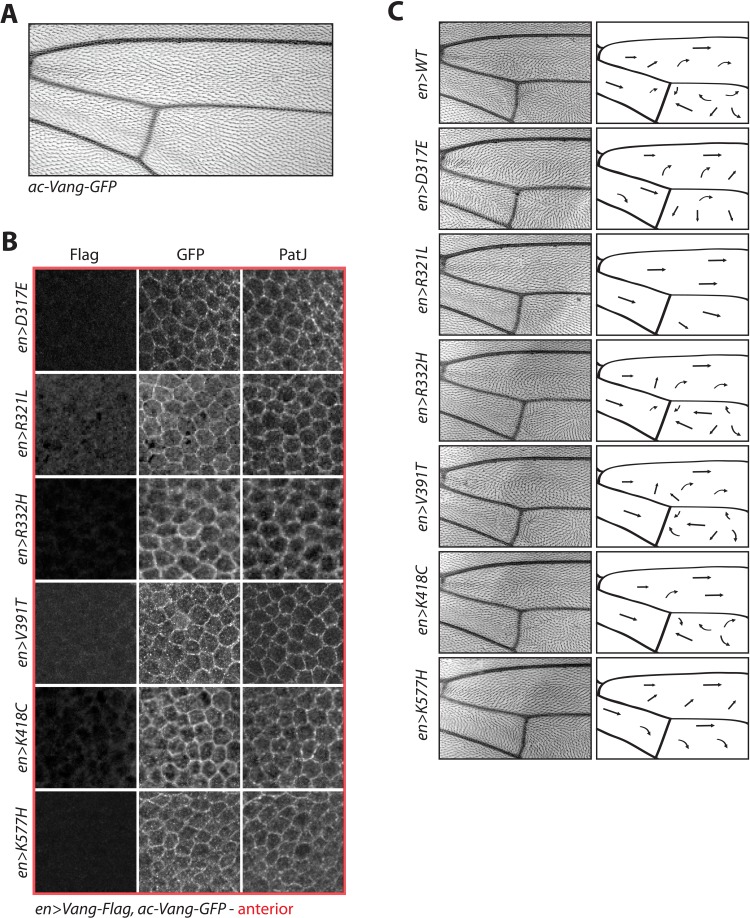
Expression of ac-Vang-GFP within the Drosophila wing blade does not interfere with polarity.(A) Image of adult wing expressing a direct driven ac-Vang-GFP transgene. Note that no hair reorientation defects are observed confirming that expression is within the homeostatic range. (B) Representative immunofluorescence images of regions from the anterior compartment of wings, the region of the wing in which engrailed-Gal4 driven constructs are not expressed. Note similarity in staining between Vang-GFP and PatJ in each condition. (C) Schematic of adult wing showing hair reorientation phenotypes in the indicated genotypes. Arrows show general flow of hair reorientation, note the similarity in pattern between overexpression of WT, R332H, V391T and K418C mutants (swirls, cf. GOF in Figure 2—figure supplement 1), as compared to R321L (wild-type orientation), and D317E and K577H (downwards reorientation, cf. LOF in Figure 2—figure supplement 1) in posterior region of the wing.